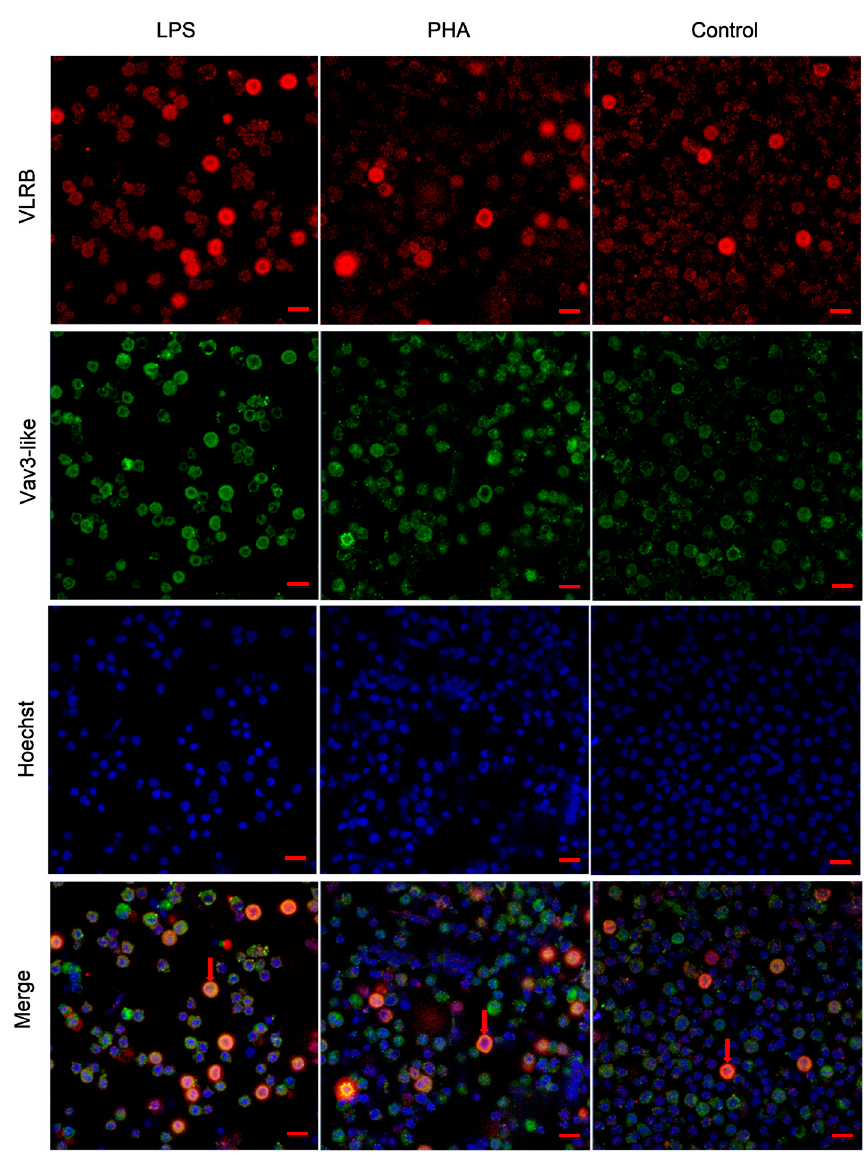
Figure 7. The distribution pattern of lamprey Vav3 in VLRB + lymphocytes after stimulation with LPS and PHA. Lymphocytes were isolated from animals before and after treated with LPS or PHA. The cells were first incubated with the rabbit anti-recombinant lamprey Vav3 poly-clonal antibody and the mouse anti-VLRB mono-clonal antibody and then were incubated with Alexa Fluor 555-conjugated goat anti-mouse IgG (red) and Alexa Fluor 488-conjugated goat anti-rabbit IgG (green), as described in Materials and Methods Section. The nuclei were stained with Hoechst 33258 dye (blue). Cells were examined by a Zeiss LSM710 confocal laser scanning microscope. The bar represents 10 µ m. The big and round cells (VLRB and lamprey Vav3 double positive) marked with arrows are plasmacytes.